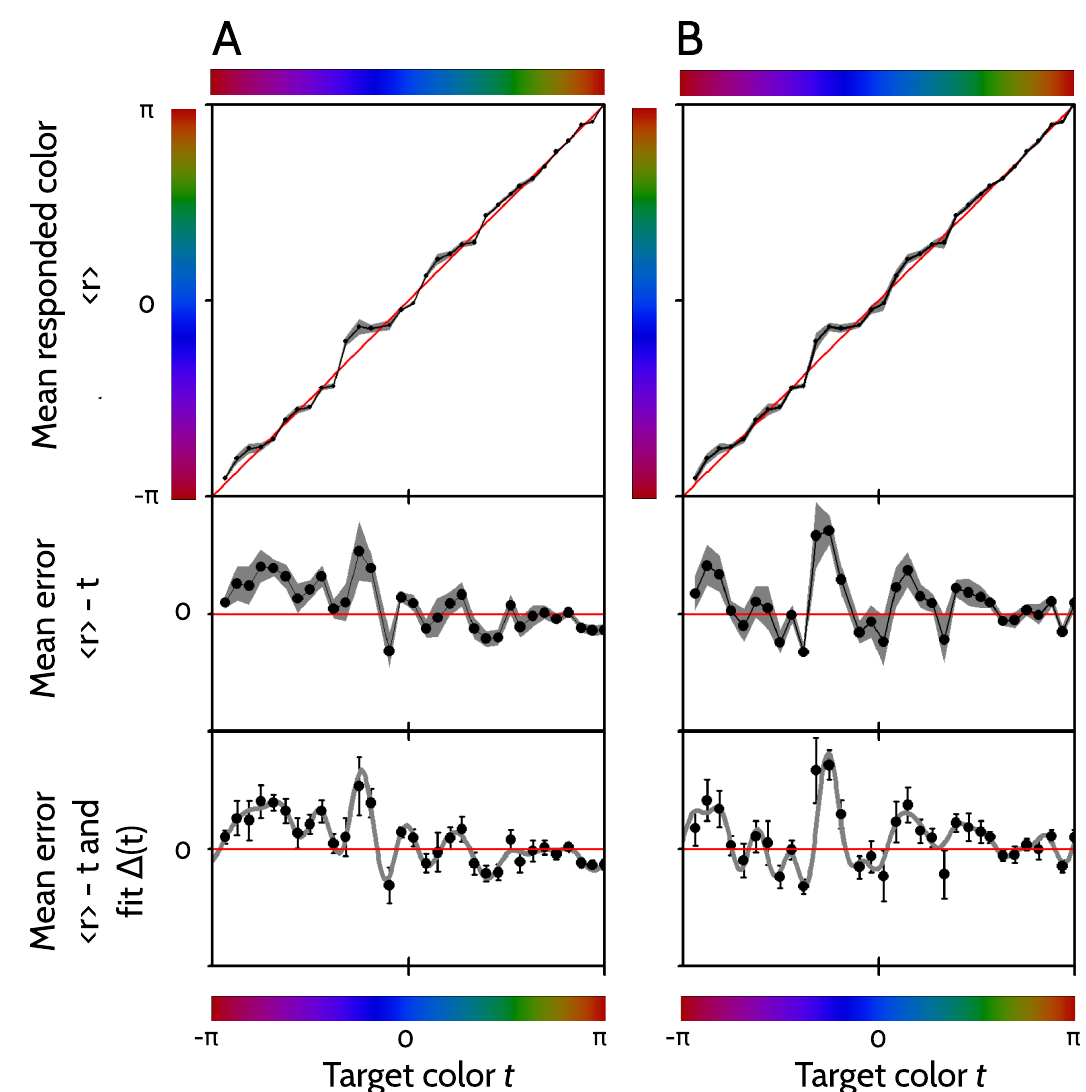
Fig 4. Characterization of the responses. Panels A and B correspond to two example players. Top: Black line: Mean response � r as a function of the target color t . Gray area: Range of values in � r ð t Þ � ε ð t Þ = expected error of the mean ε ð t Þ = and the expected error of the mean ε ð t Þ = π